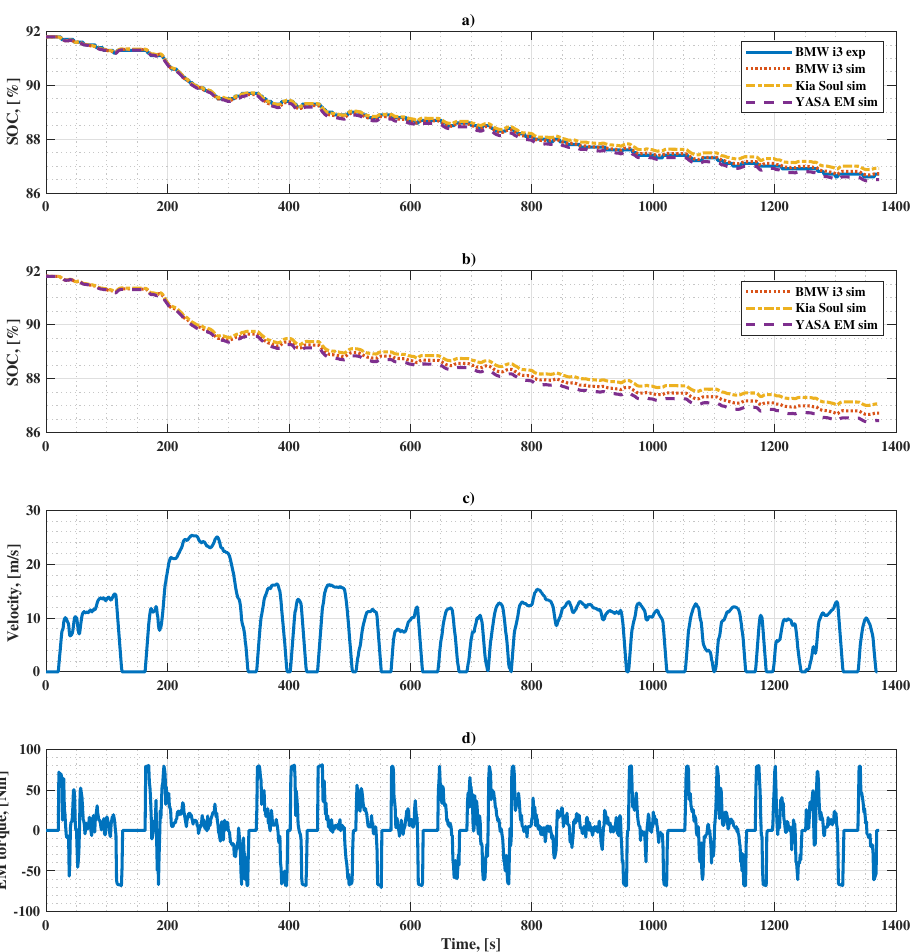
loads. As shown in Figure 10, the solid blue line (BMW i3 exp) represents the experimental data overlaps with the dotted red line (BMW i3 sim) obtained during the simulation. The dash-dot yellow line (Kia Soul sim) is the result of simulation using the re-scaled Kia Soul EM, which has higher final SOC due to higher efficiency points during the operation. For the re-scaled YASA EM (YASA EM sim, dashed purple line), the consumption is slightly more with respect to others, hence the final SOC is lower.